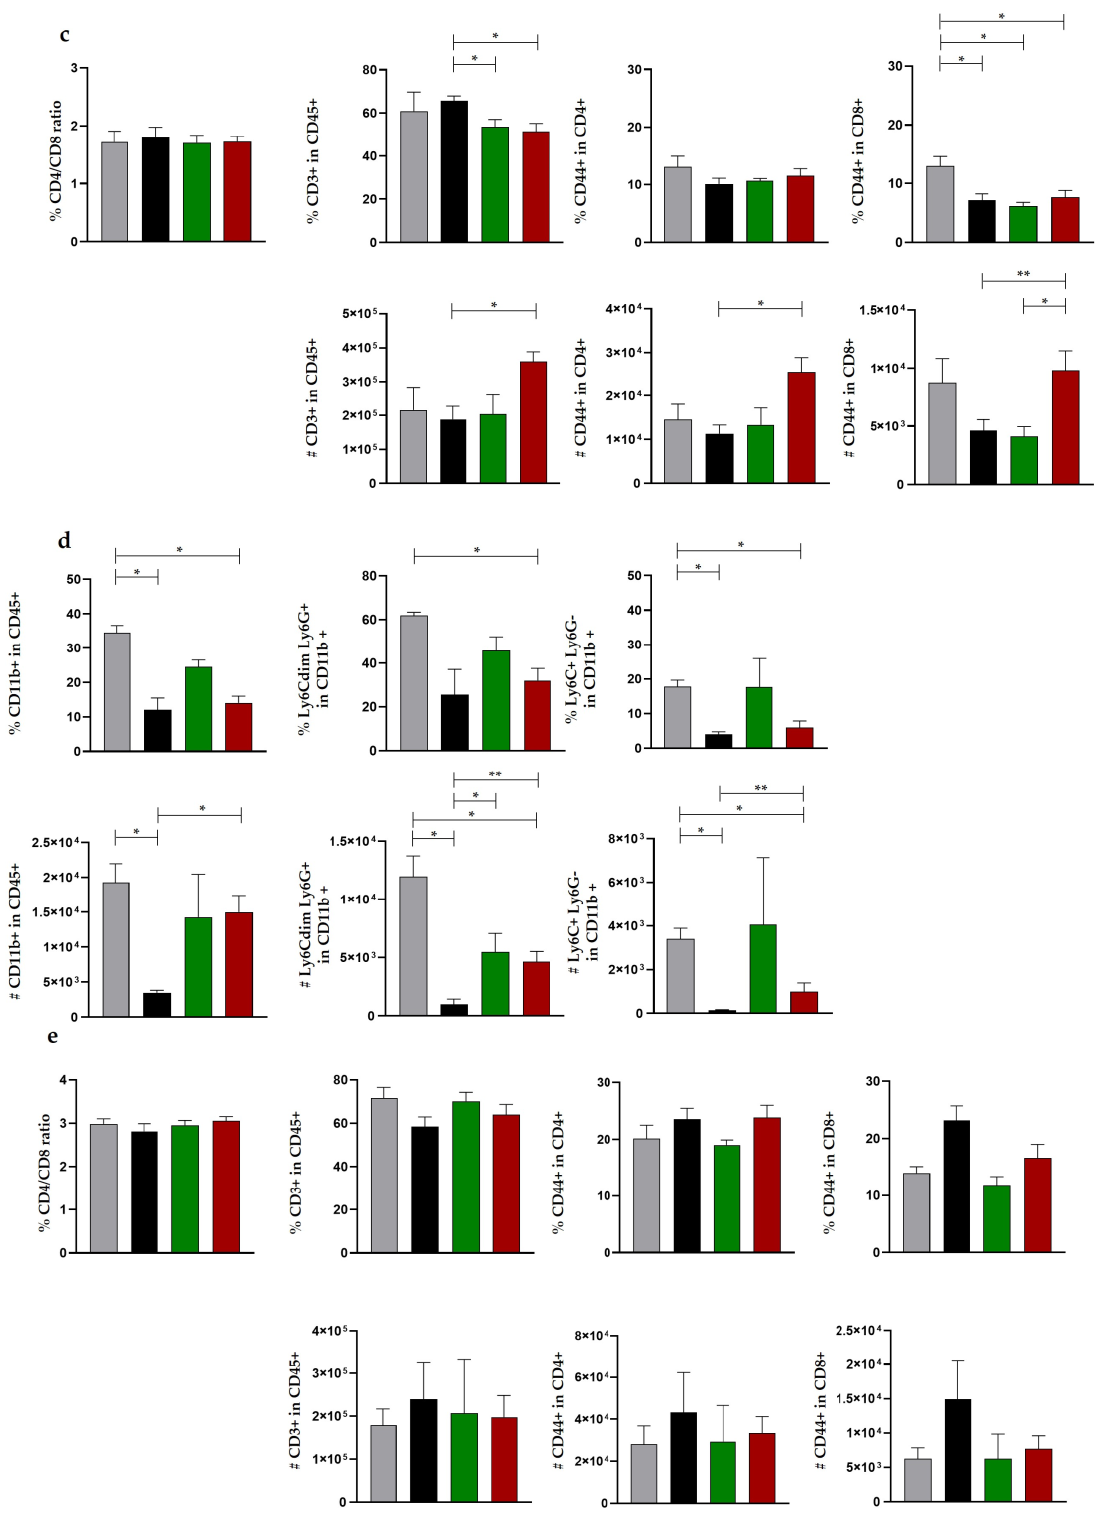
Figure 10. The immune cell profile in various tissues as a result of the treatments. Changes in the proportions and numbers of T lymphocytes in tumor tissue ( a ), change in myeloid cell percentages and numbers in tumor tissue ( b ), T lymphocyte numbers and percentages in the spleen ( c ), percentages and quantities of myeloid cells in the spleen ( d ), T lymphocyte numbers and percentages in the lymph node ( e ), (* p < 0.05, ** p < 0.01). The total amount of T cell populations in the spleen was decreased in the 5-FU+IL-2 solution and 5FU/IL2/CD2 nanoplex groups compared with the 5-FU solution group. When evaluated numerically, the 5FU/IL2/CD2 nanoplex group significantly increased the T cell population compared with the 5-FU solution group. While there was no signif- icant difference in the percentage of the CD4 + T mem cell population in the spleen, a